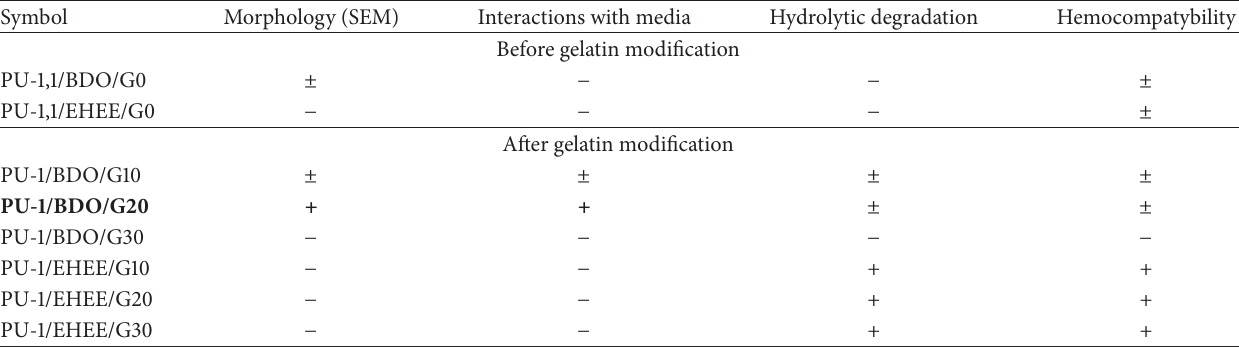
Table 8: The summary of unmodified and modified PUs interactions with media, hydrolytic degradation, morphology, and hemocompati- bility. Symbol Morphology (SEM) Interactions with media Hydrolytic degradation Hemocompatybility Before gelatin